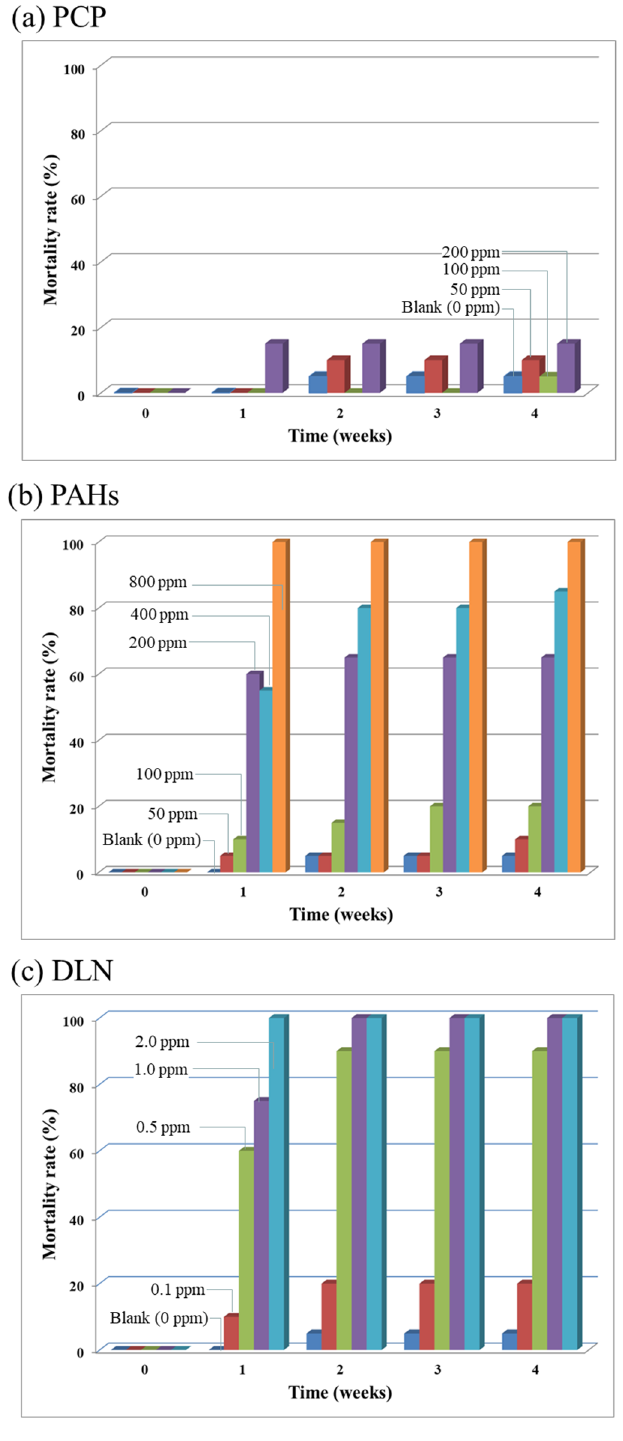
Figure 1. Mortality rates of beetle larvae in the presence of PCP, PAHs and DLN, as labeled in ( a – c ), respectively.